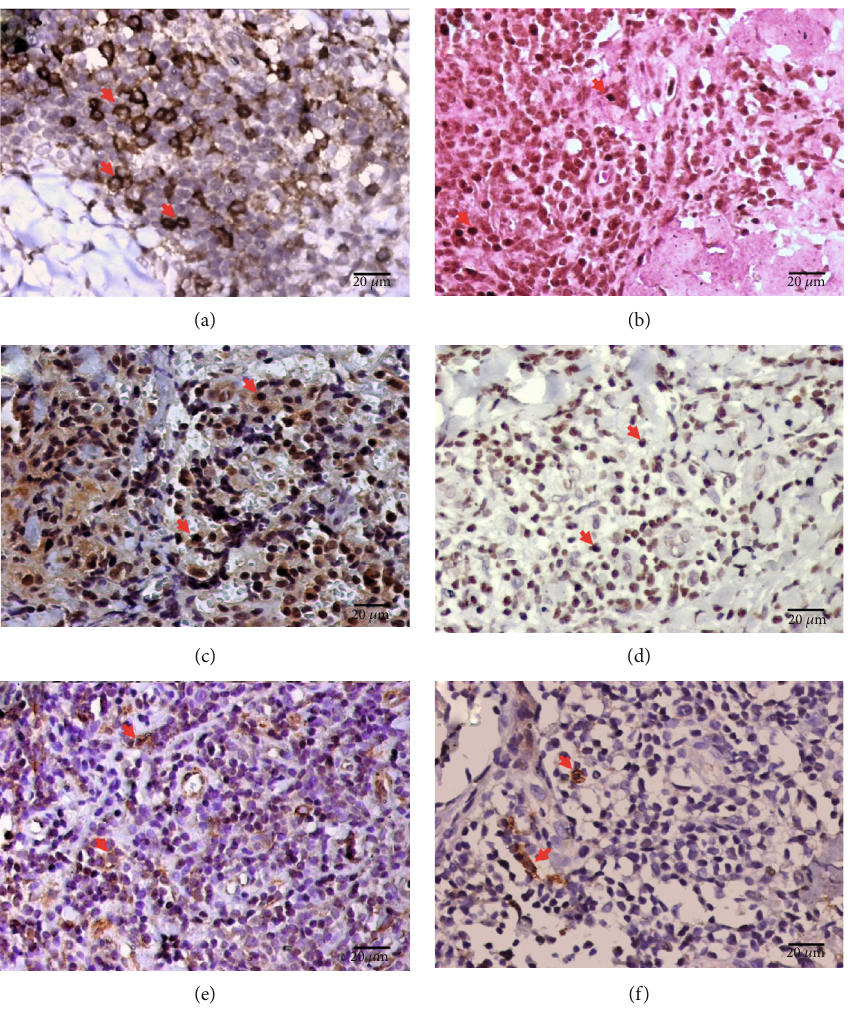
Figure 1: Immunohistochemistry of the skin sections from the patients with LCL; brown CD4 + cells (a), RoR γ t + cells (b), IL-17 + cells (c), IL- 23 + cells (d), IL-6 + cells (e), and TGF- β + (f) cells can be observed. The red arrow shows positive cells.